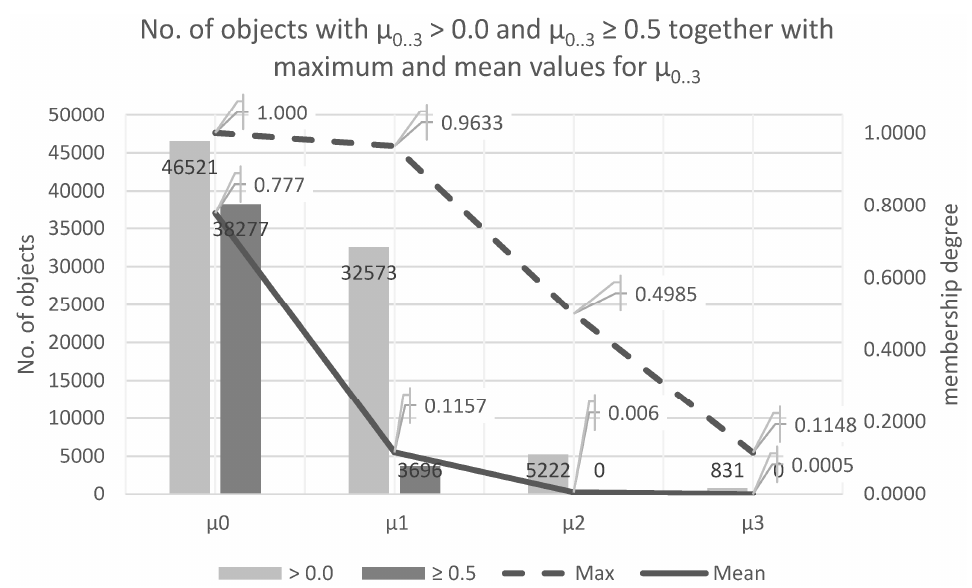
Figure 4. Descriptive statistics of µ 0 , µ 1 , µ 2 and µ 3 of “urban green” for the OBIA fuzzy classification result ( L -classes) of the WV-2 scene of Munich.